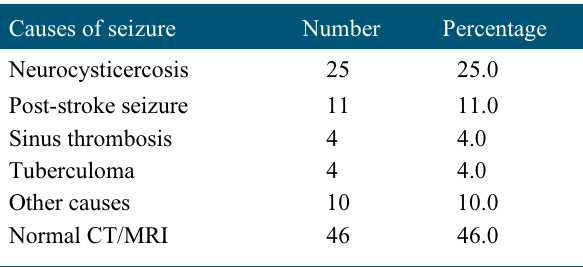
Table 4: Causes of seizure from the imaging ndings